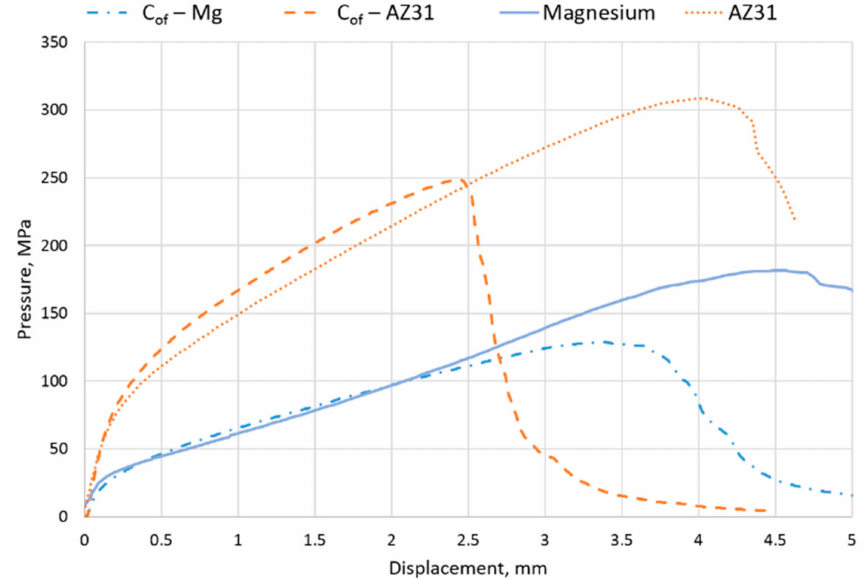
Figure 10. Typical curves of flexural strength tests obtained for manufactured composites and reference matrix alloys.